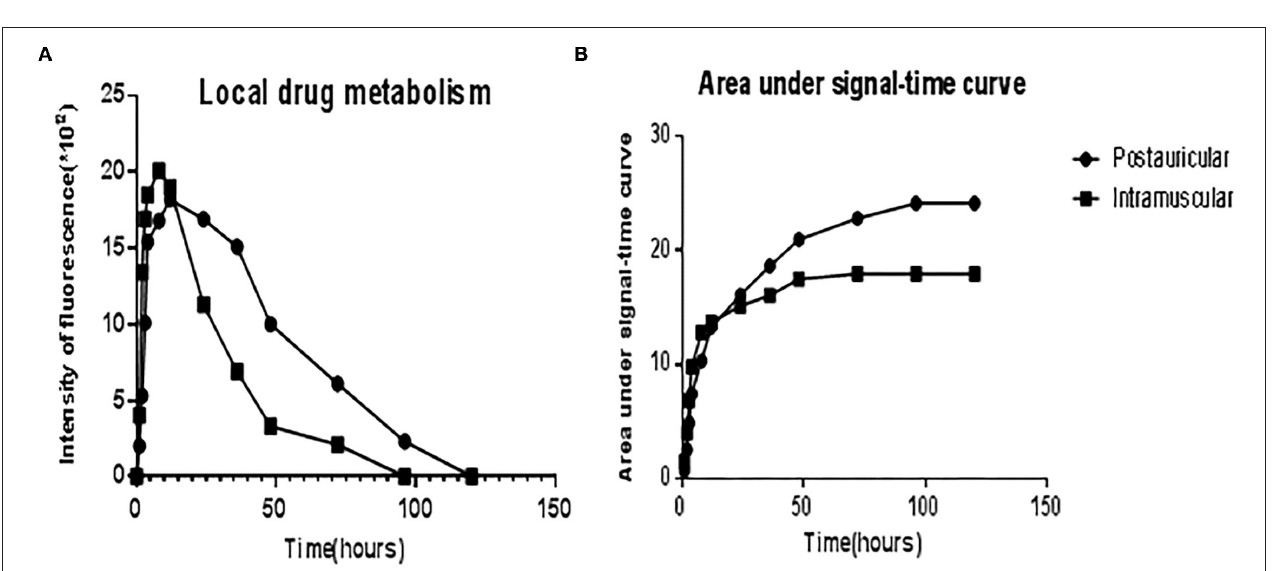
FIGURE 2 | The curve showed the fluorescence intensities of local drug metabolism (A) and the area under signal-time curve (B) between the postauricular and intramuscular injection groups.